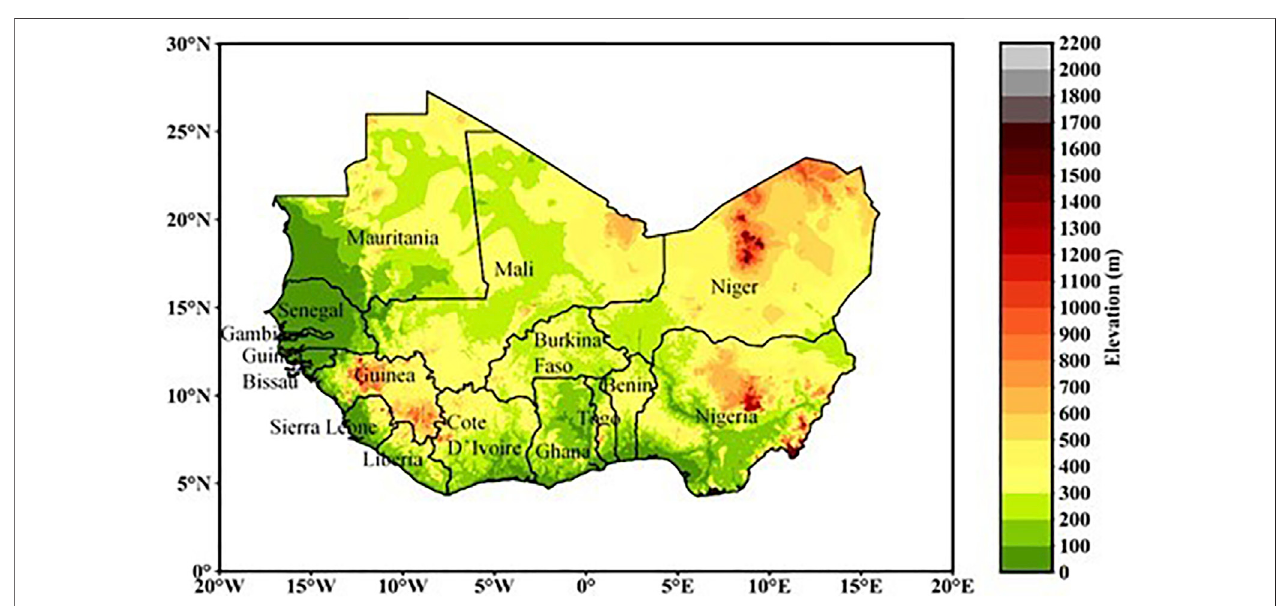
FIGURE 1 | Map of the study area showing the elevation of the study domain. The division is between the Guinea Coast and Sahel. Gnitou et al., 2019.